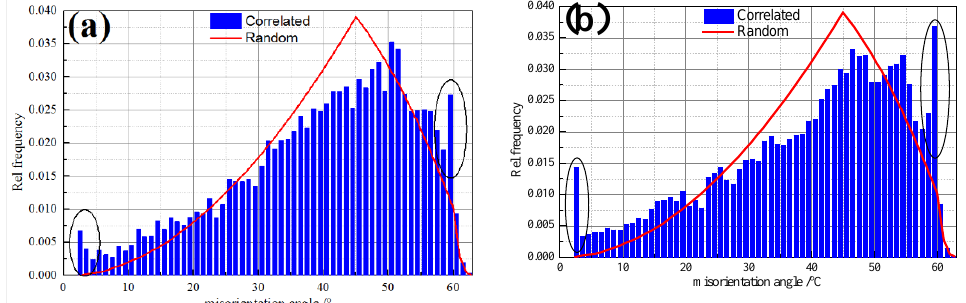
Figure 13. Misorientation distributions of different C content: ( a ) ELC; ( b ) LC.